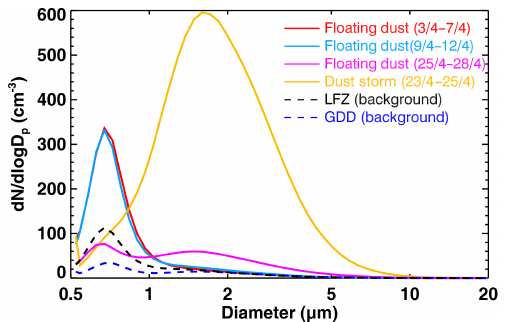
Figure 12. Average aerosol size distribution (d N / dlog D p , cm − 3 ) based on all run data collected under different weather conditions during the entire